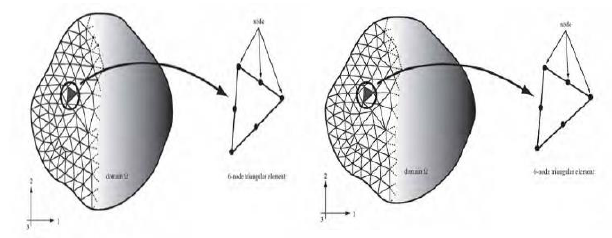
Figure 3: Finite Element Discretization in 2D